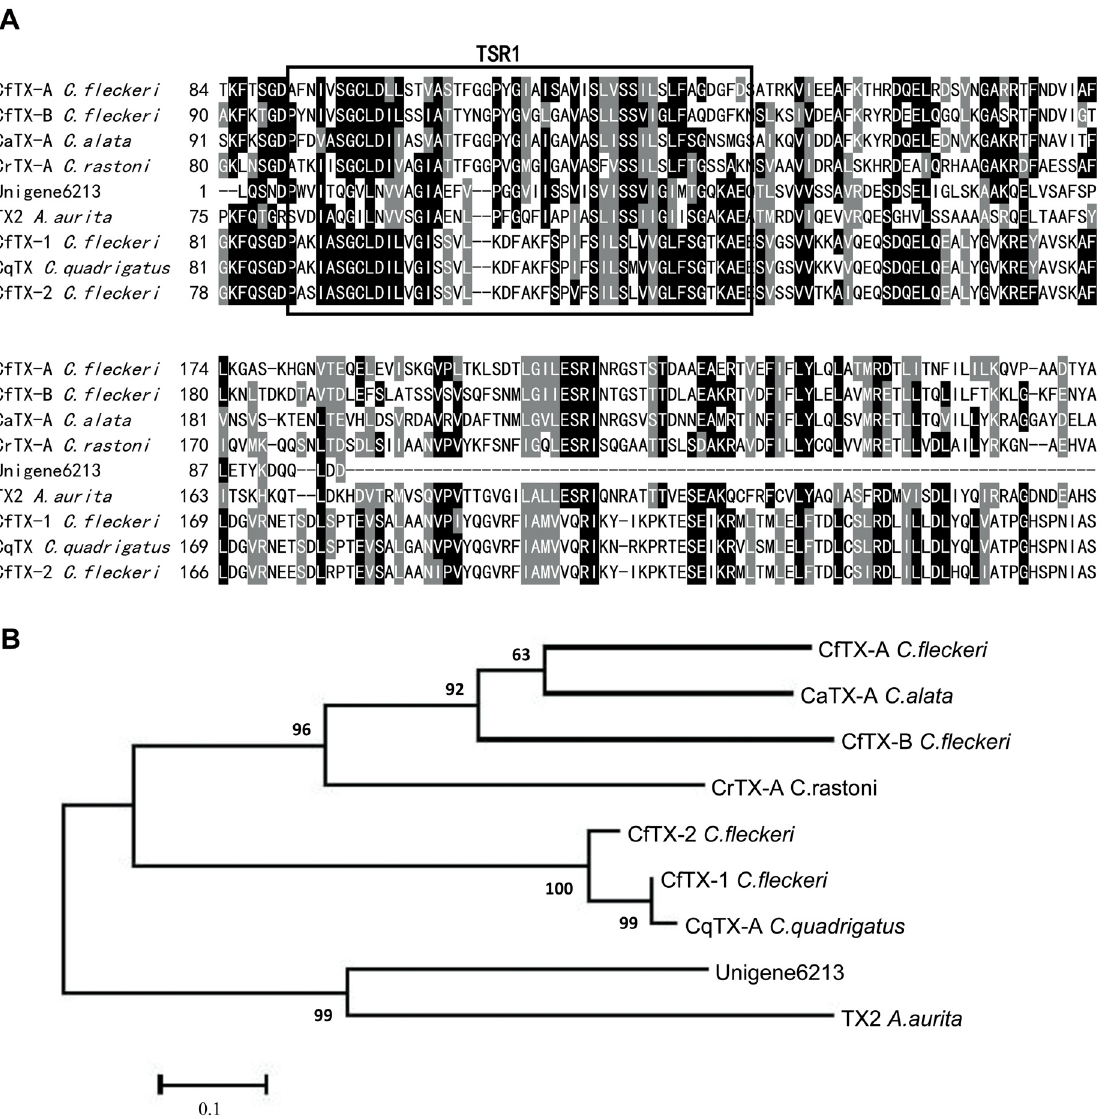
Fig 5. (A) Multiple sequence alignment of the amino acid sequence of unigene 6213 with other known CfTX-like cnidarian toxins. The abbreviations and sequence accession numbers for the aligned sequences are as follows: Aurelia aurita TX2 (AFK76349), Chiropsalmus quadrigatus